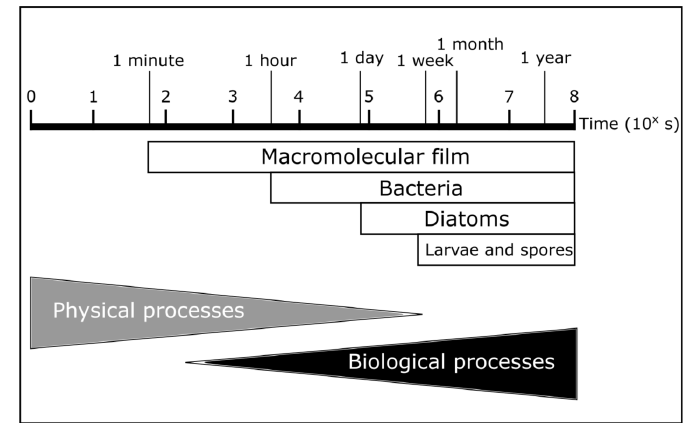
Figure 14. Schematic colonization process leading to establishment of a fouling whole [26]. c (cid:13) Reproduced with permission from European Wave and Tidal Energy Conference,